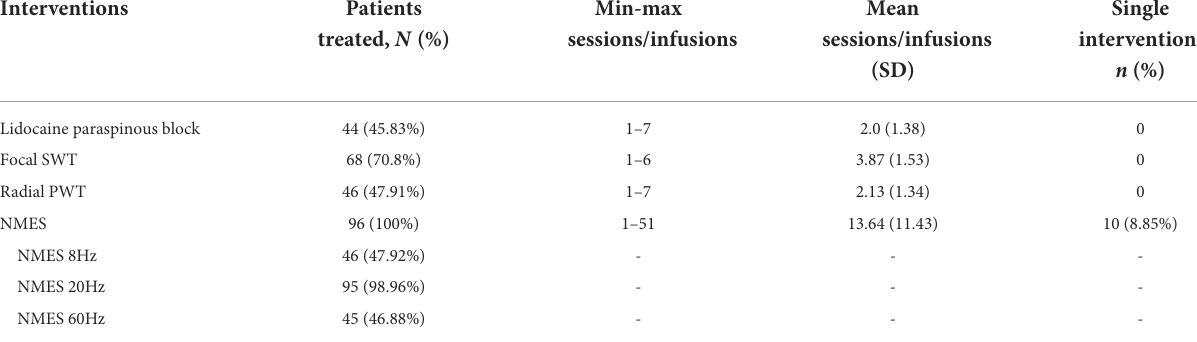
TABLE 2 Treatment distribution. Interventions